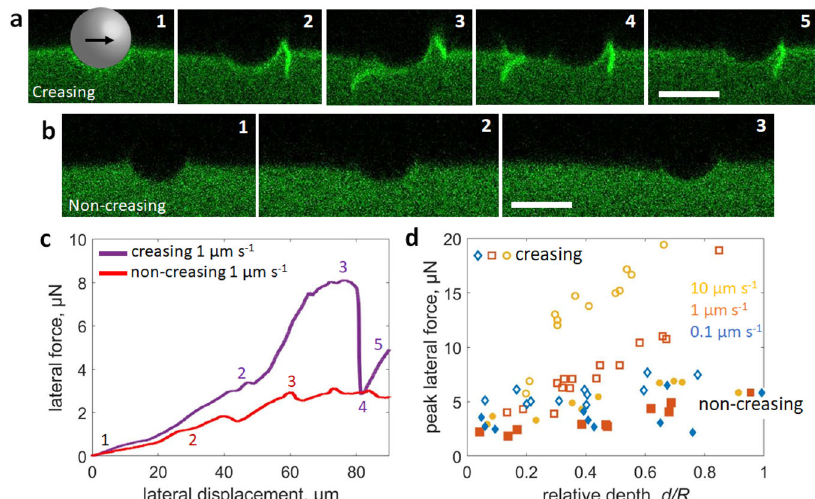
d = R =0.4. b 1 The microsphere in contact with the surface prior to the start of motion. b 2 The contact shape is about midway to the peak lateral force ( F peak ). b 3 The contact shape once the lateral force F L has reached an approximate force plateau. c Lateral force ( F L ) vs lateral displacement curves for creasing and non- creasingsamples.Thenumberedpointscorrelatewiththeconfocalimagesinparts ( a )and( b ). d Thepeaklateralforce ð F peak Þ forcreasingandnon-creasingsamplesas a function of d = R and v . Scale bars: 20 μ